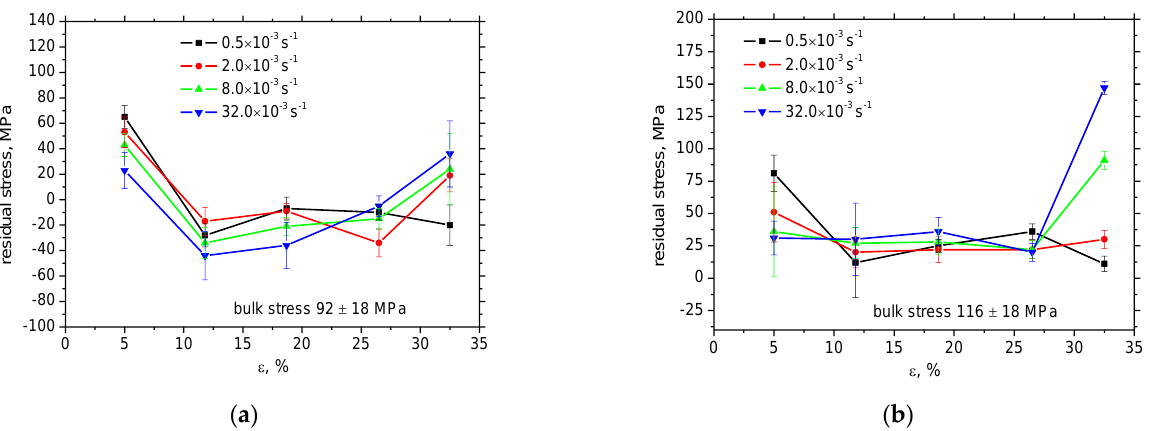
Figure 8. Evolution of residual stresses as a function of plastic strain and strain rate. ( a ) RD, ( b ) TD.